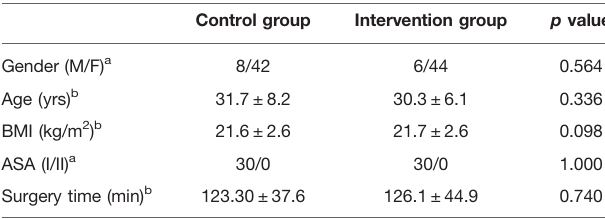
TABLE 2 | Patients ’ demographic data and surgery